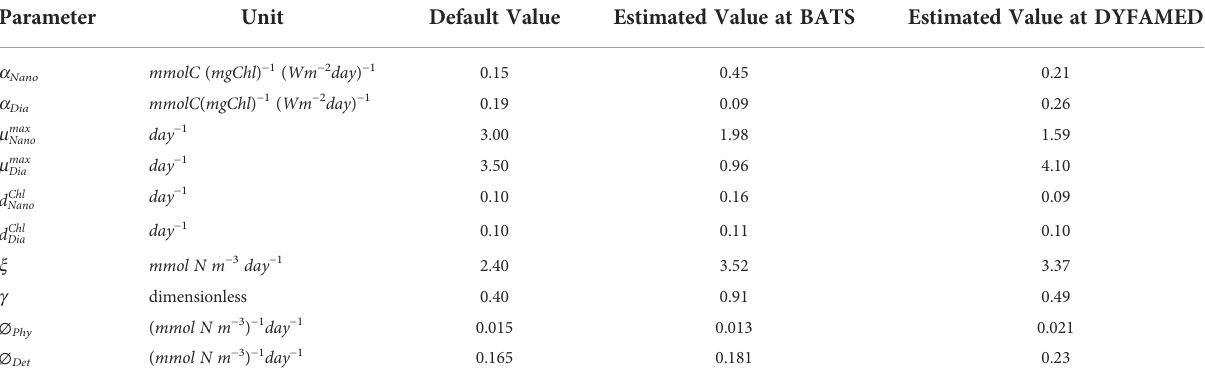
TABLE 1 The 10 BGC parameters that are estimated in this study: the default and the estimated values. Parameter